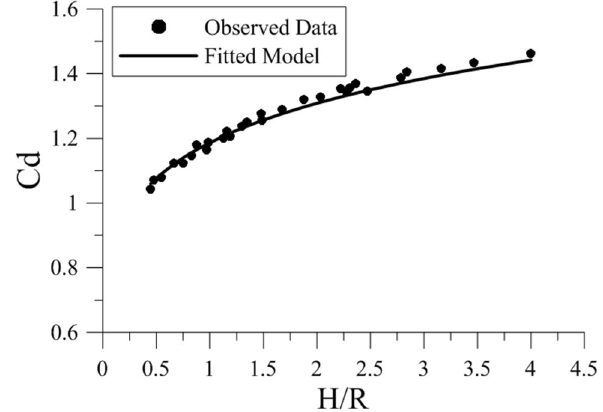
Fig. 2 The values of Cd of circular crested weirs versus the H/R (Mohammadzadeh-Habili et al.